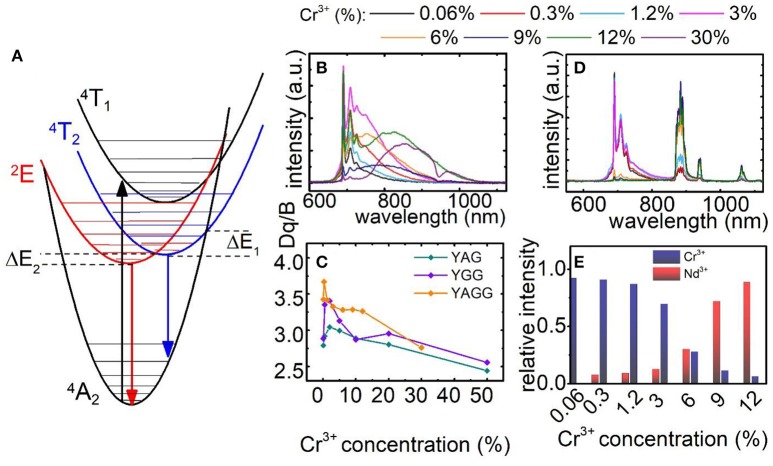
Configurational coordinates diagram of Cr3+ ions (A); comparison of normalized emission spectra for Y3Al2Ga3O12: xCr3+
(B) and for Y3Al2Ga3O12: xCr3+, 1%Nd3+ nanocrystals (D); dependence of Dq/B parameter (C) and Cr3+/Nd3+ ratio at T = −150°C (E) on Cr3+ concentration.